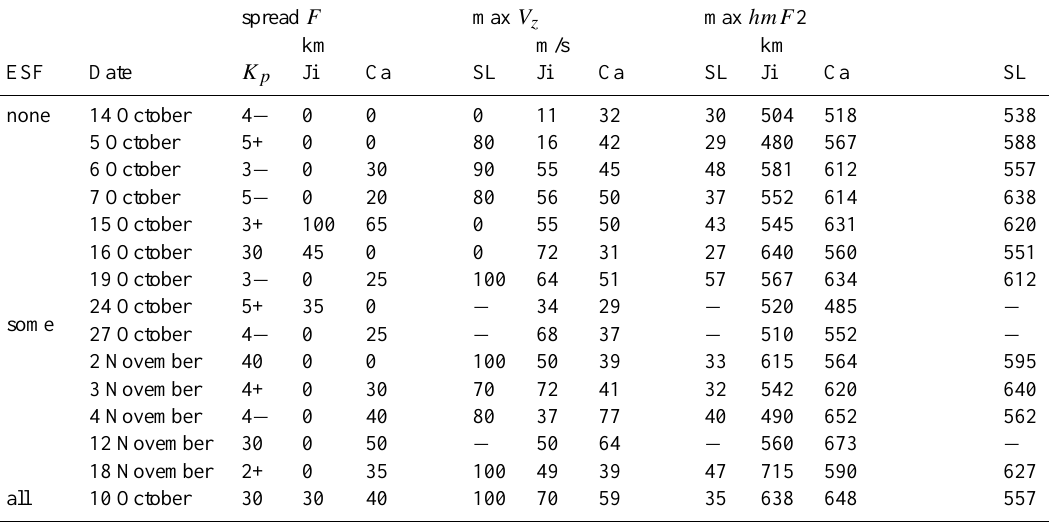
Table 1. Range spread, maximum vertical drift at prereversal enhancement, and the maximum F2 layer peak height for October and November 2002, grouped into all sites quiet (none), some but not all sites with ESF activity (some), and one example for all three sites active (all). A dash indicates “no data”.